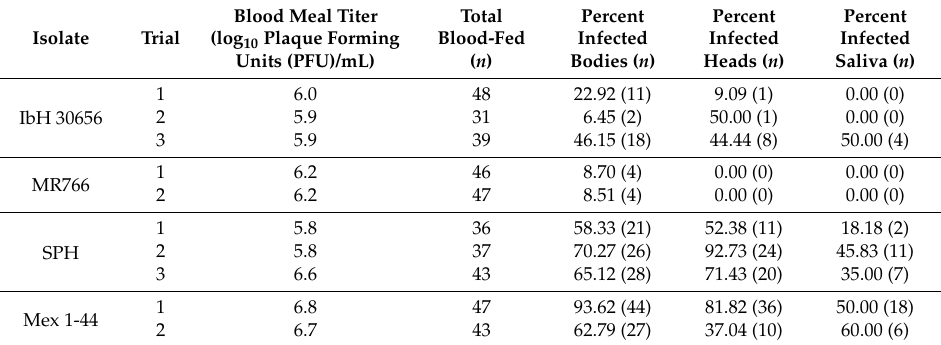
Table 3. Summary of mosquito infection data.